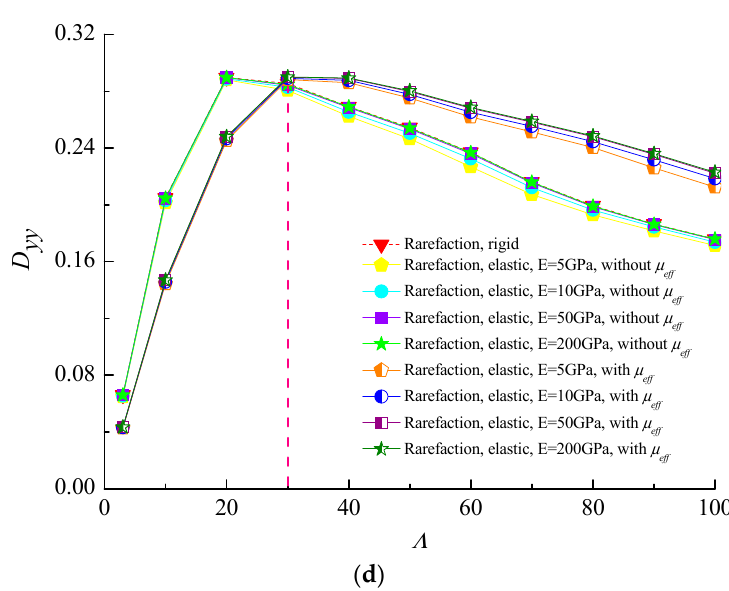
Figure 11. Dynamic stiffness and damping coefficients as functions of bearing number for different values of elastic moduli when considering or not considering the effective viscosity. ( a ) K xx vs. Λ ; ( b ) K yy vs. Λ ; ( c ) D xx vs. Λ ; ( d ) D yy vs. Λ ( Ω = 3.5, ε = 0.7, υ = 0.3).